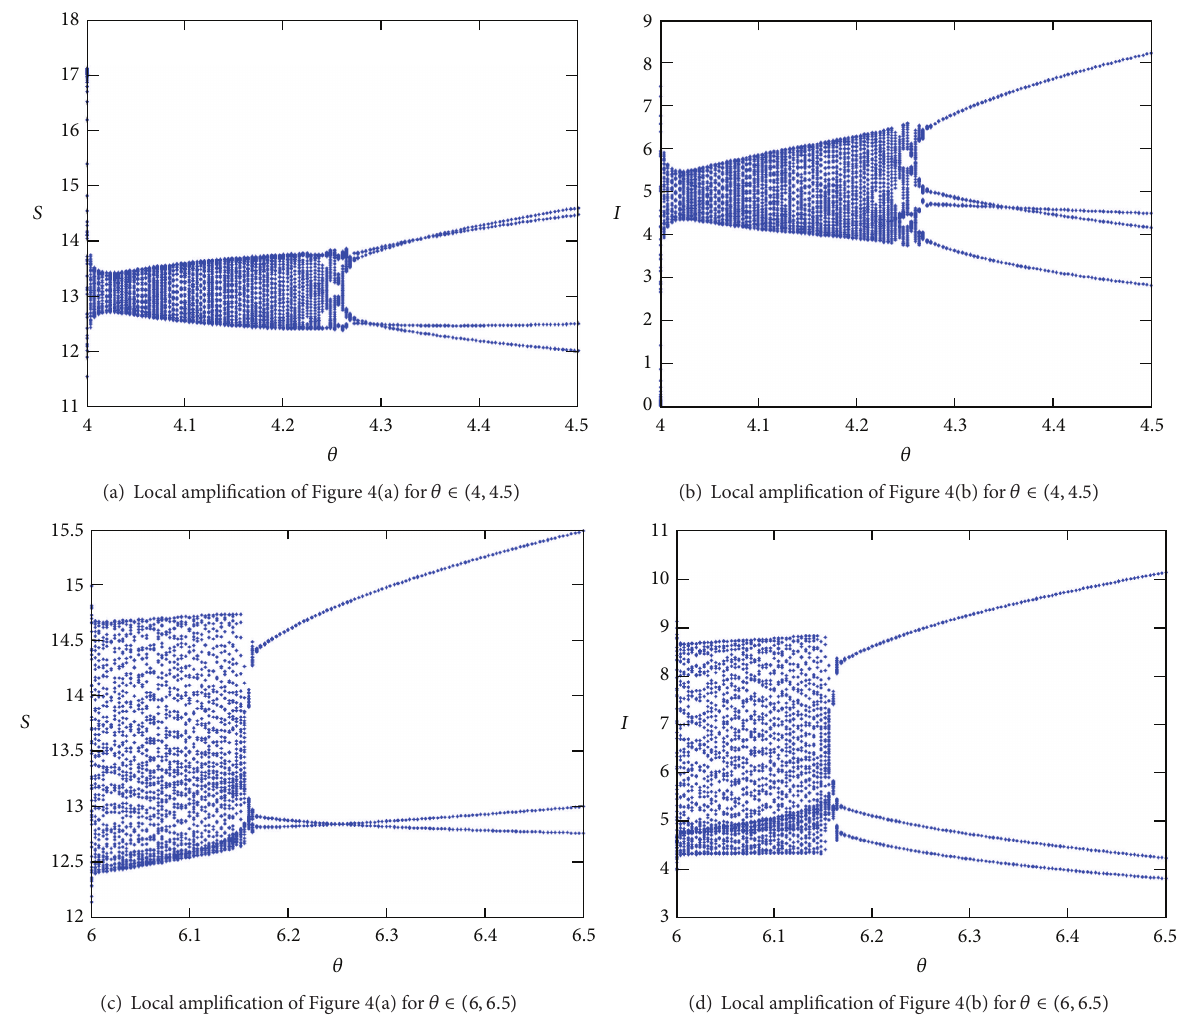
Figure 5: Bifurcation diagrams of system (8) with respect to 𝜃 in case (2) of Section